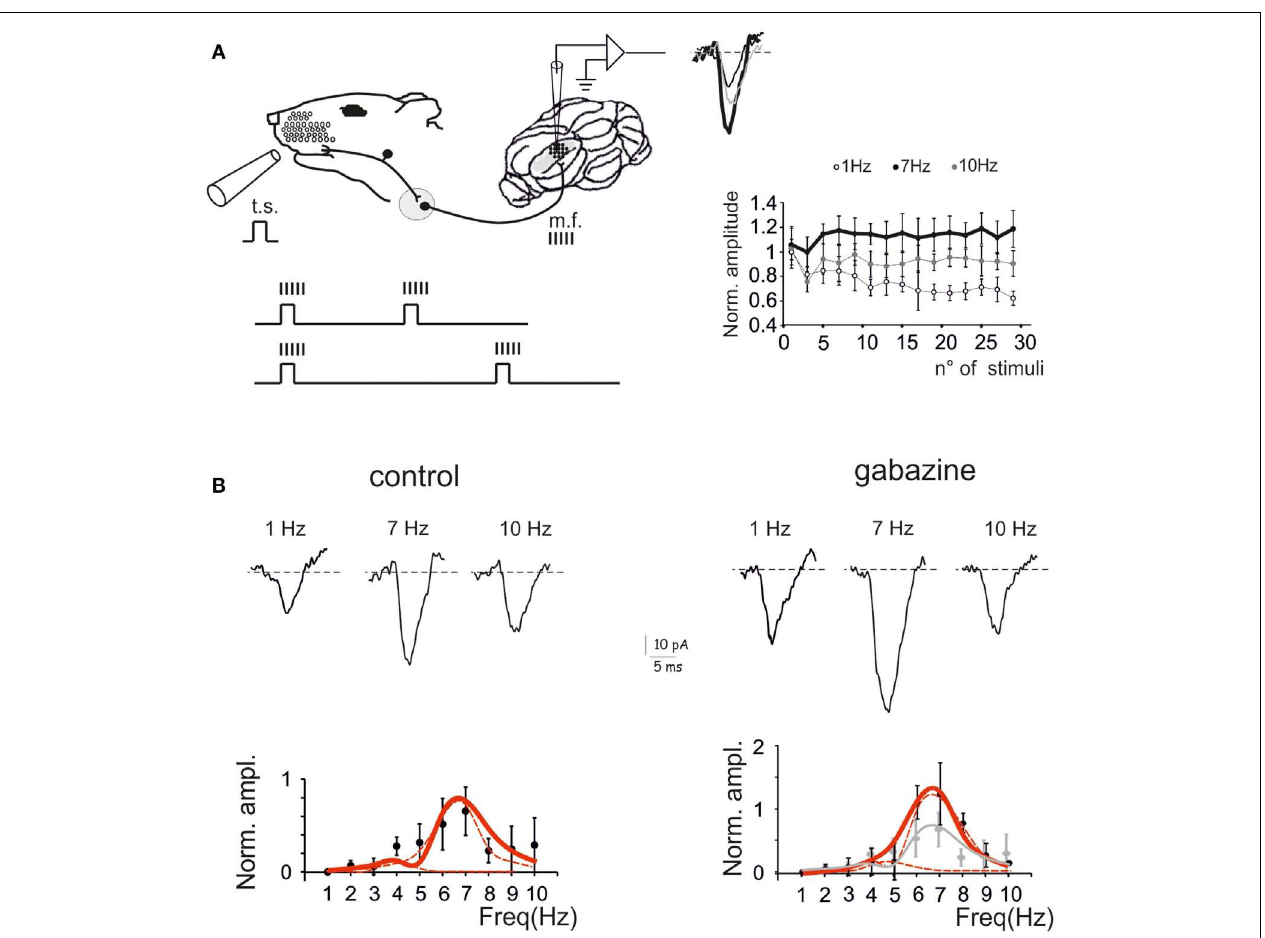
subsequent pulses at three different stimulus frequencies. (B) LFPs recorded from the GRL at different frequencies of sensory stimulation in control and after intracerebellar microperfusion of gabazine.The normalized maximum LFP amplitude is reported in the plots. Note resonance at 5–7Hz, which is maintained in the presence of gabazine. Data are reported as mean ± SEM. Red lines fitting the data point represent double Lorentzian functions (broken lines are the two individual component functions) obtained on control and gabazine data,